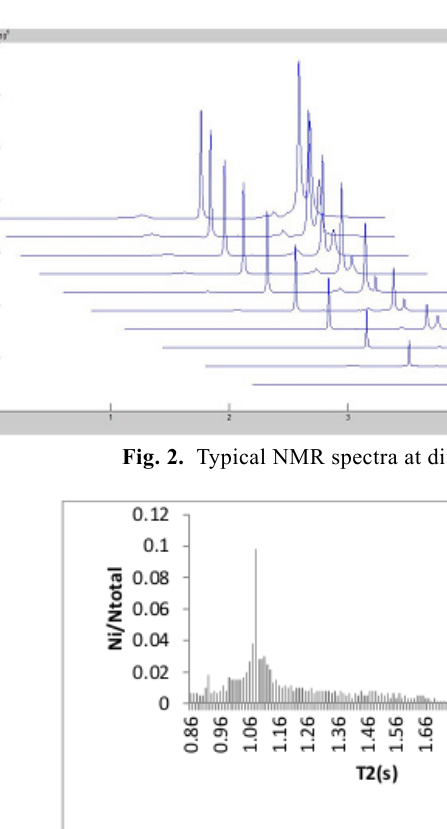
Fig. 3. T distribution related to water/oil emulsion at 30% water/oil volume ratio. 2